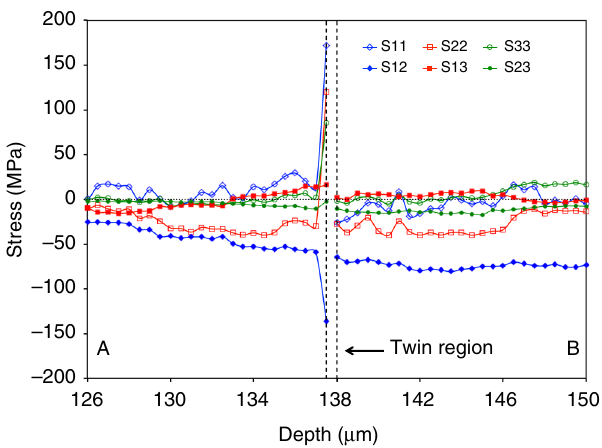
Fig 2 Distribution of stress and strain components. Spatial distribution of elastic strain and stress components along a line A-B, shown in this fi gure that crosses tensile twin. The directions 1, 2 and 3 correspond to [112 ̄ 0], [011 ̄ 0] and [0001] directions of crystal coordinate system, respectively.